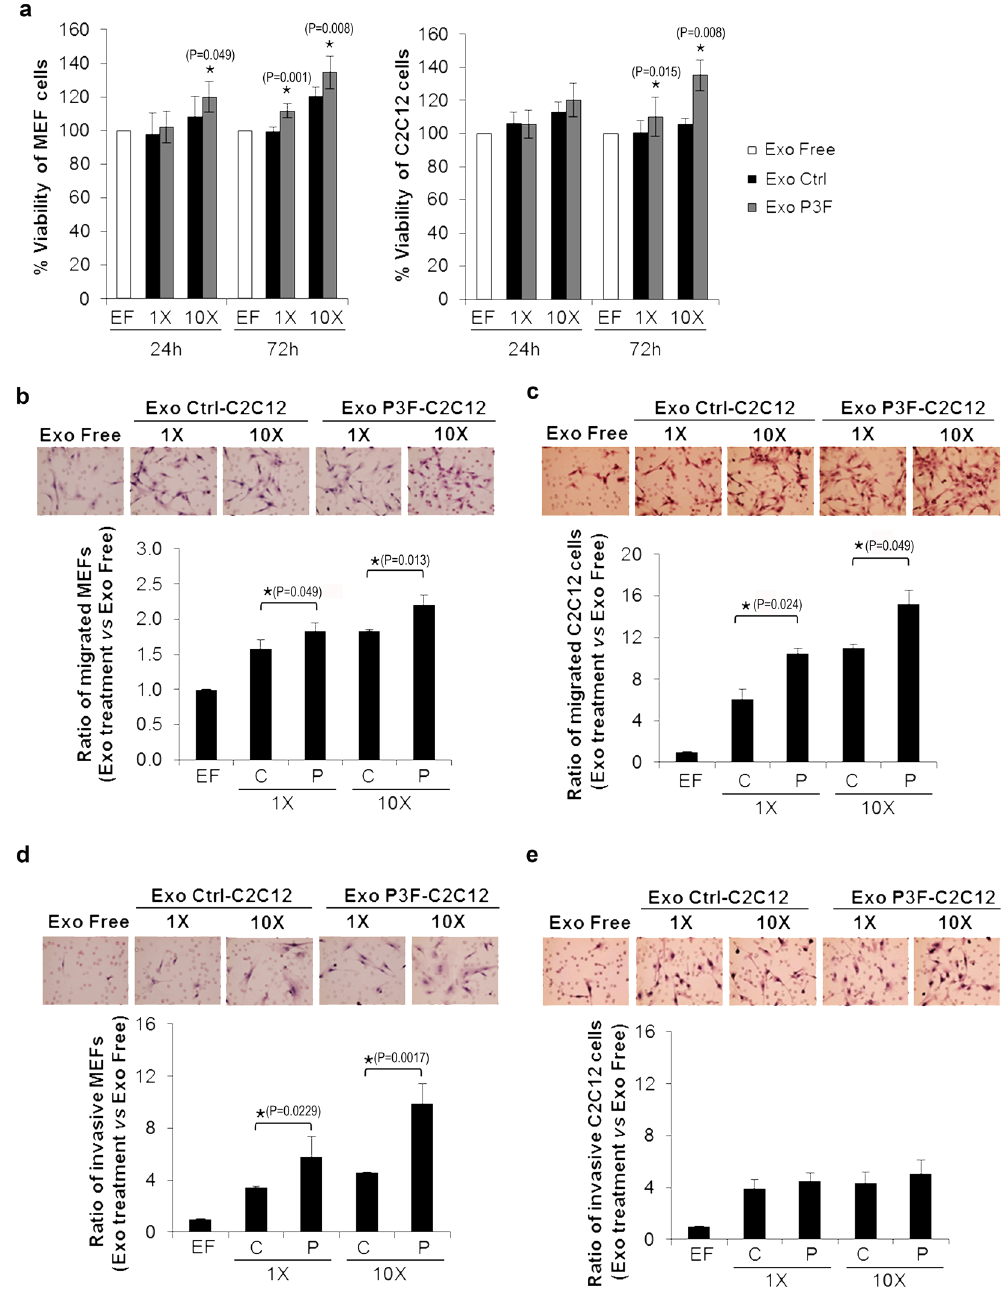
Figure 2. P3F-C2C12-derived exosomes promote proliferation, migration and invasion of recipient cells. ( a ) MTT assay performed on MEFs (left panel) or C2C12 cells (right panel) treated with the indicated amount of exosomes (Exo) for 24 or 72 hours, as indicated. Control condition is cells treated with exosome-free media. ( b – e ) Representative photomicrographs for transwell migration assay of MEFs ( b ) and C2C12 cells ( c ), and transwell invasion assay of MEFs ( d ) and C2C12 ( e ) treated with specified amount of exosomes (1X and 10X) for 24 hours, compared to control (treated with exosome-free media) cells. Histograms represent quantitation of the cell ratio versus control at the denoted conditions. Bars represent standard deviation. Asterisks denote a statistically significant difference (p-value <